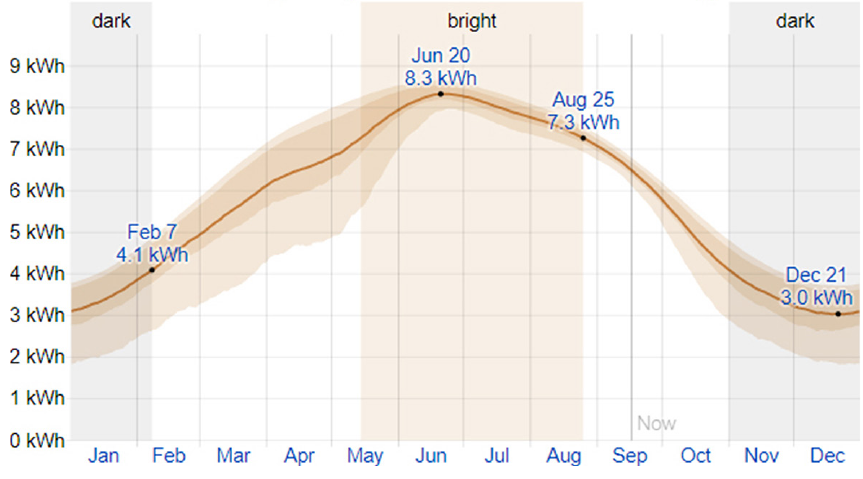
Fig. 2. Average radiation in Al-Rifai